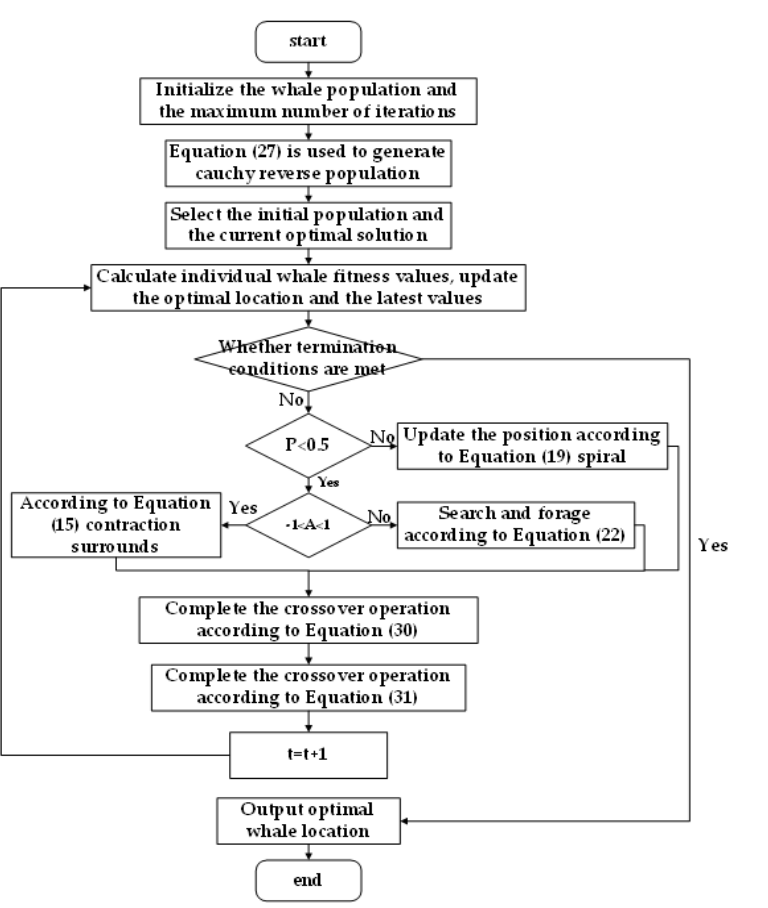
Figure 9. Whale optimization algorithm optimization flow chart with the DE algorithm.